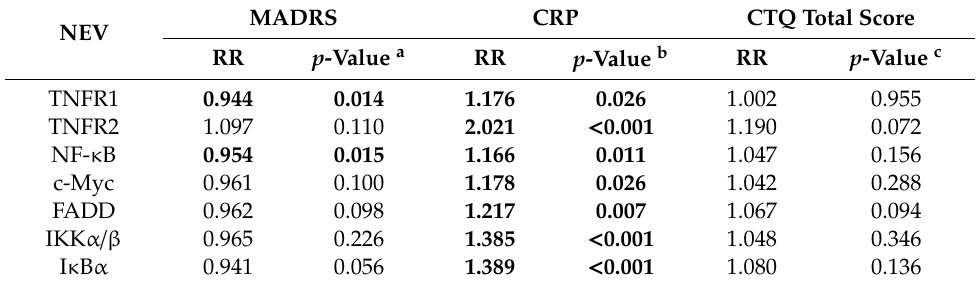
Table 2. Associations between NEV biomarkers and Montgomery–Asberg Depression Rating Scale (MADRS), C-reactive protein (CRP), and Childhood Trauma Questionnaire (CTQ), at